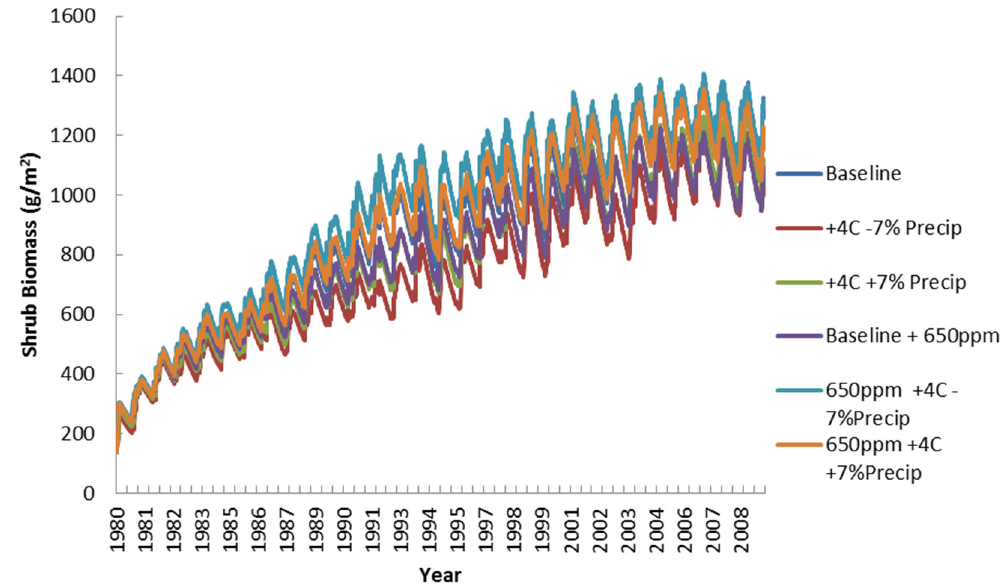
Figure 16. Simulated shrub biomass (g/m 2 ) for all climate scenarios.